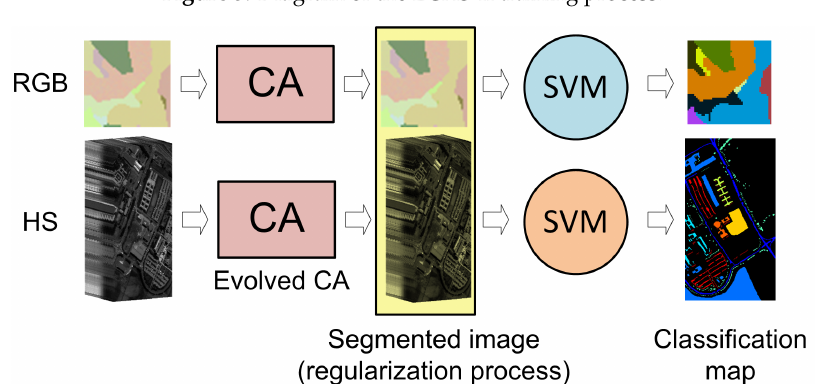
Figure 5. Diagram of the ECAS-II training process.